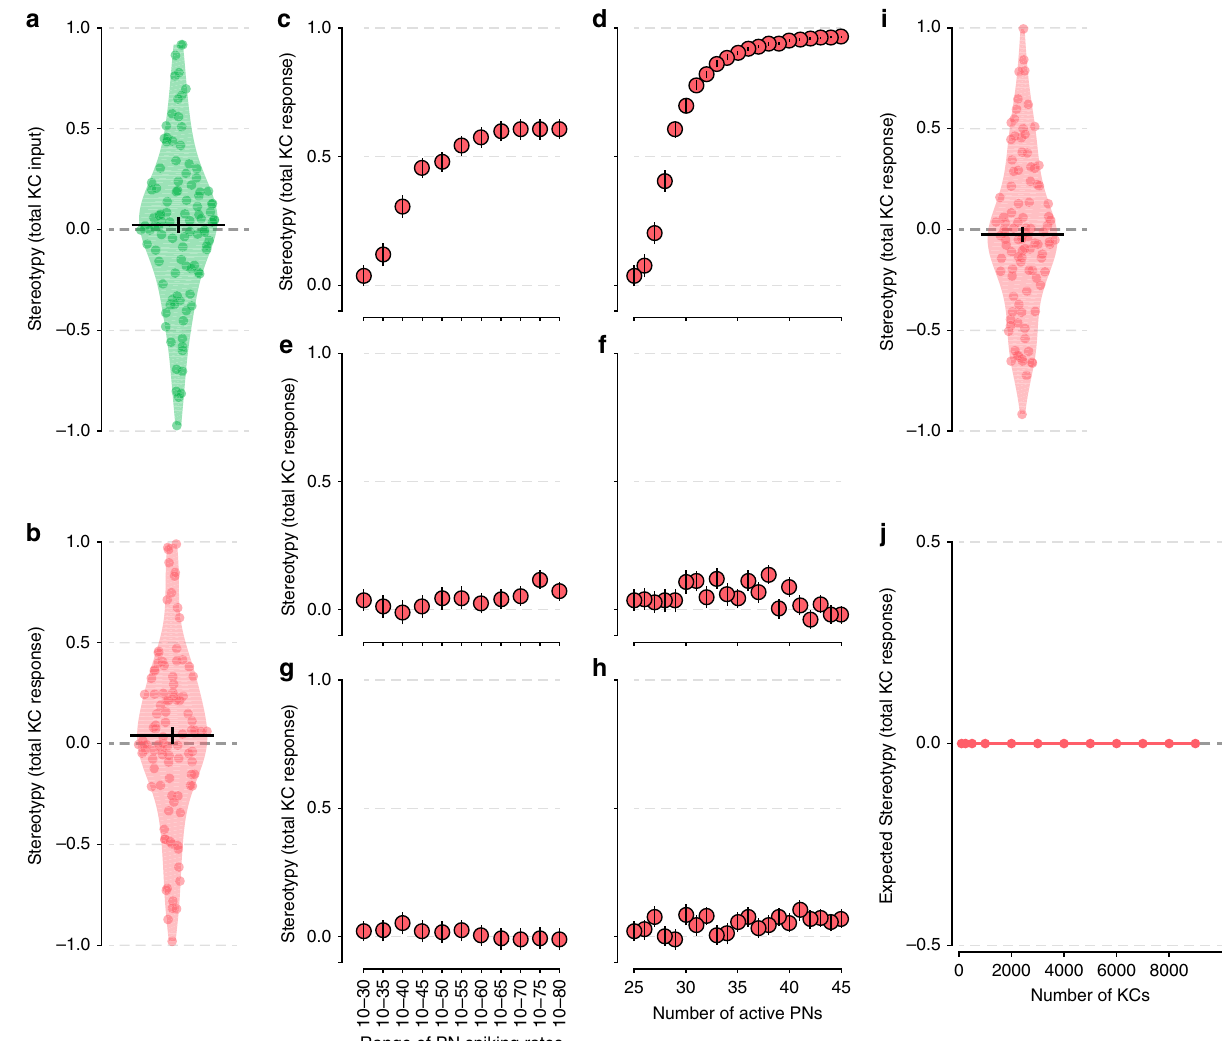
Fig. 5 Stereotypy in simulations with the same input drives for both odors. a , b Stereotypy in total KC input ( a ) and total KC response ( b ) when the total input drives to both odors are equal. c Stereotypy in total KC response versus the range of PN spiking rates when the range of spiking rates is changed to the indicated values for one odor while it is maintained at 10 – 30 for the other. d Stereotypy in total KC response versus the number of active PNs when the number is changed to the indicated values for one odor while it is maintained at 25 for the other. e Similar to ( c ) except that the range of PN spiking rates is changed for both odors. f Similar to ( d ) except that the number of active PNs is changed for both odors. g , h Plots similar to ( c ) and ( d ), respectively, but with the modi fi cation that a linear transfer function, y i = mx i − t , is used to generate KC responses from their inputs. Here, y i is the response of the i th KC, x i is the input to the i th KC, t is the threshold, and m is chosen such that the total KC responses are equal to those seen in the default simulations. i Stereotypy in total KC response when the PN responses to the second odor are generated by shuf fl ing the PN labels in the response to the fi rst odor. In this condition, the total PN output, the number of active PNs, and the spiking range of active PNs are identical for the two odors. j Analytical model con fi rmed that there is no stereotypy, regardless of the number of KCs, when the PN responses to the two odors are shuf fl ed versions of each other. In all panels, n = 100 iterations; error bars represent